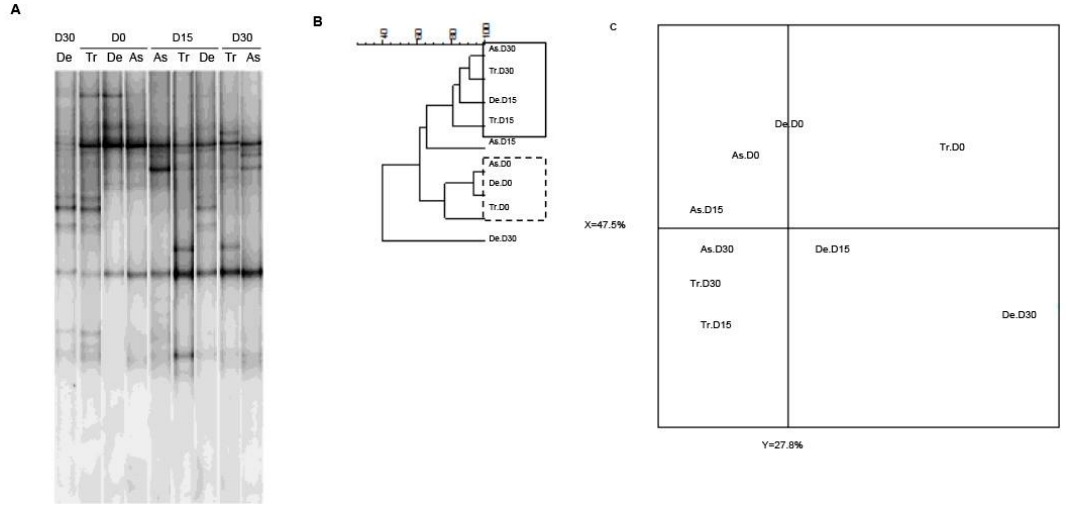
Figure 4. The Temporal Temperature Gradient Gel Electrophoresis (TTGE) fingerprint for total bacteria in the three colon reactors after 0, 15 and 30 days of exposure to CPF 1 mg/day in oil (D0, D15 and D30, respectively). ( A ) TTGE of all bacterial 16S rRNA gene amplicons in fecal samples collected from the colon vessels (As: ascending; Tr: transverse; De: descending); ( B ) The Pearson dendrogram for samples from each reactor at D0, D15 and D30; ( C ) The results of a PCA of samples from each reactor. The x and y values were 47.5% and 27.8%, respectively.